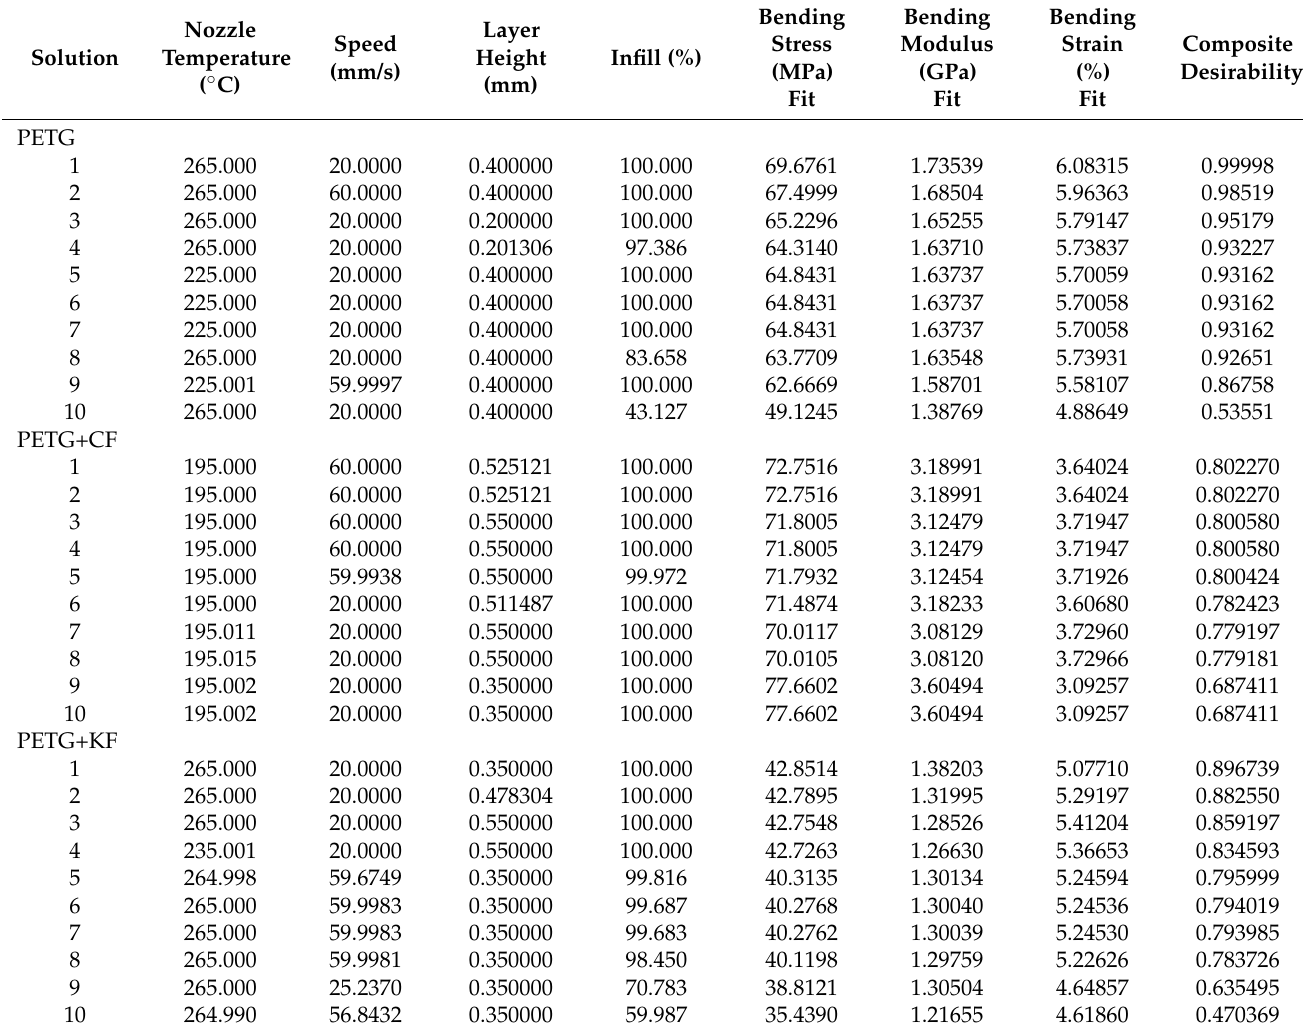
Table 11. Optimal 10 solutions obtained by desirability function for all materials.